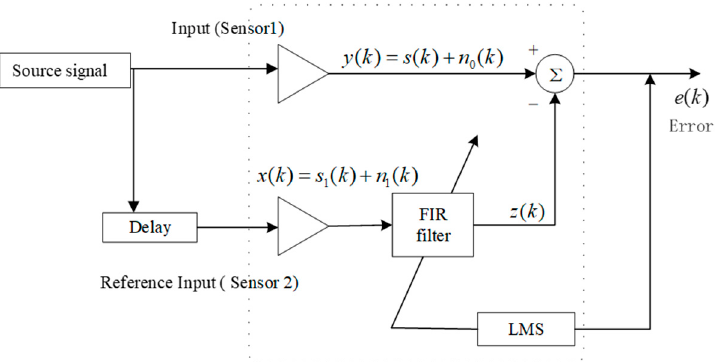
Figure 9. Block diagram of